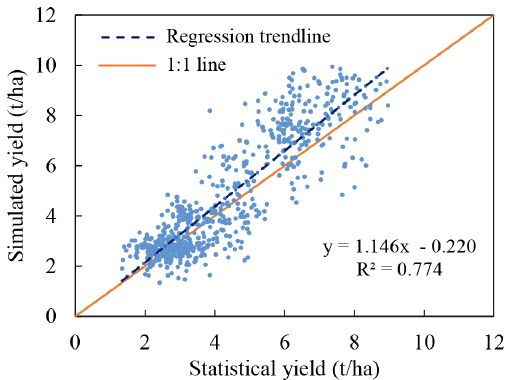
Figure 3. Comparison of national winter wheat yield reported by FAO and simulated by calibrated EPIC during the period from 1974–2004 (excluding calibration year of